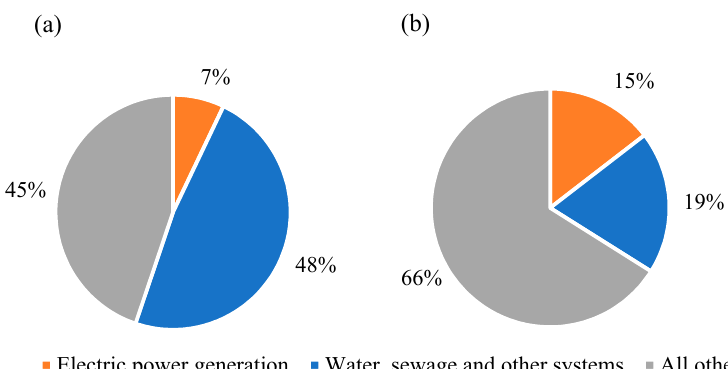
Figure 4. Average annual incidents of ( a ) injuries and illnesses and ( b ) fatalities reported by Electric power generation (NAICS 22111) and Water, sewage and other systems (NAICS 22113). Other represents remaining illnesses, injuries and fatalities within Utilities (NAICS 221) for comparison.